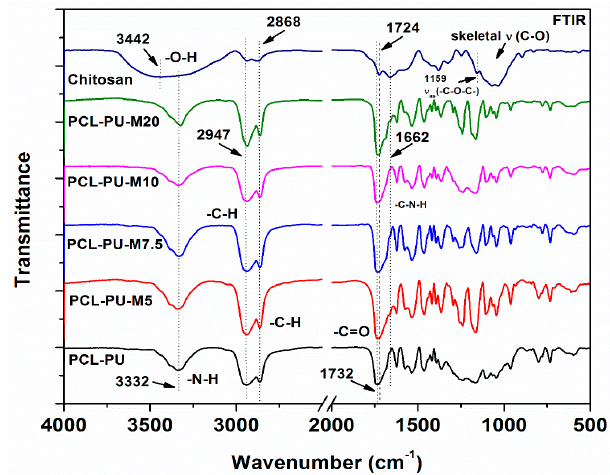
Figure 1. FTIR spectra of Chitosan, polycaprolactone-polyurethane (PCL-PU), and PCL-PU-Chitosan biocomposites.